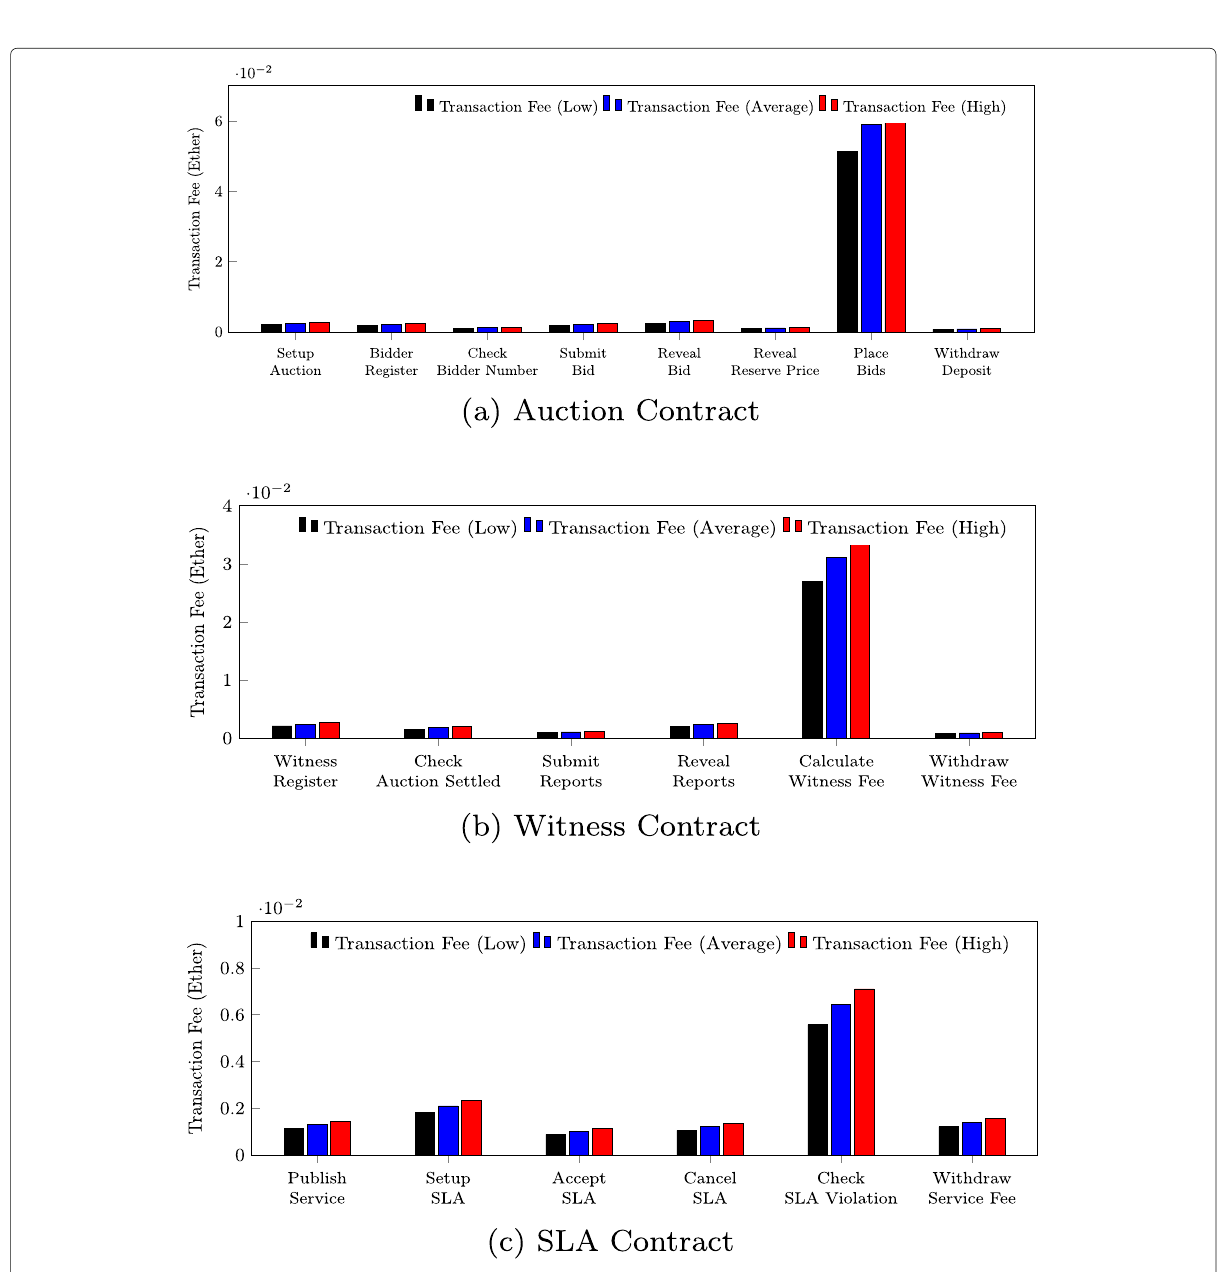
Fig. 14 The transaction fee of each function interface in AWESOME smart